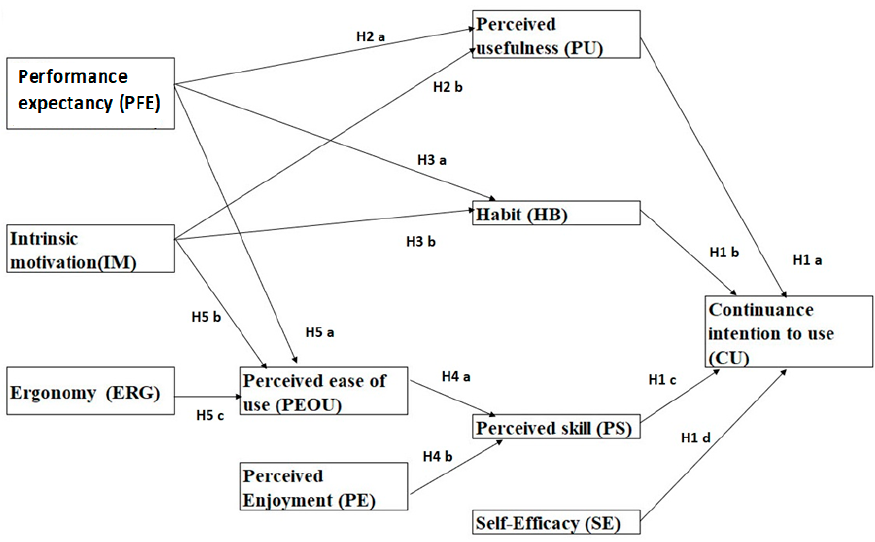
Figure 1. The research model and hypothesis.